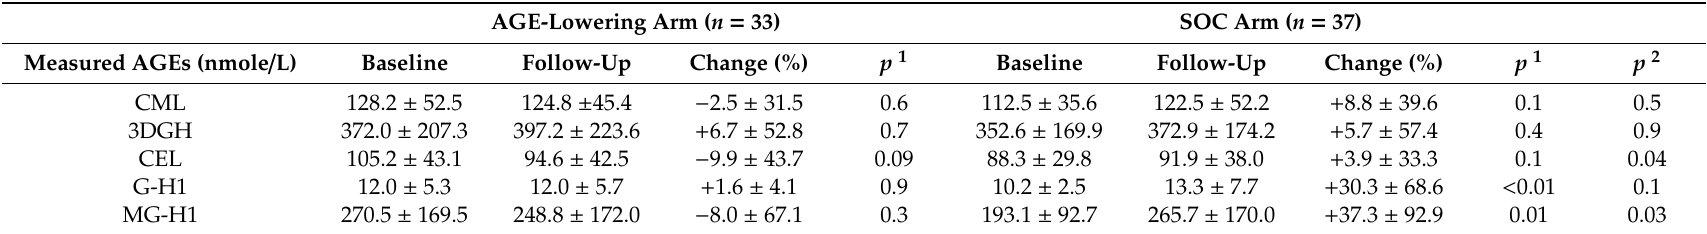
Table 3. E ff ect of intervention on serum AGEs concentration (ITT analysis).